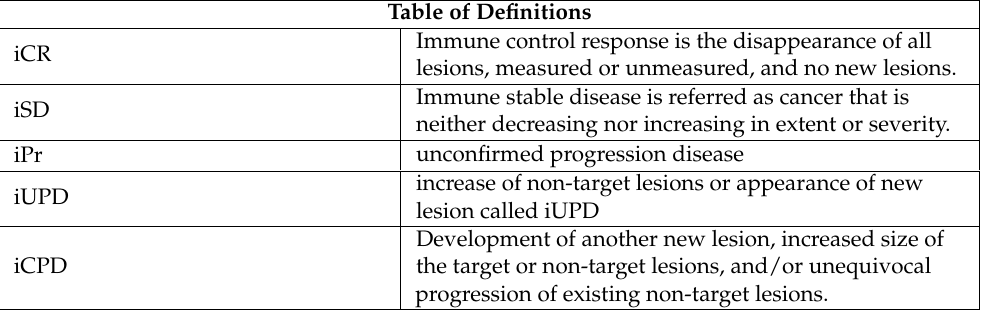
Table 2. Table of definitions.